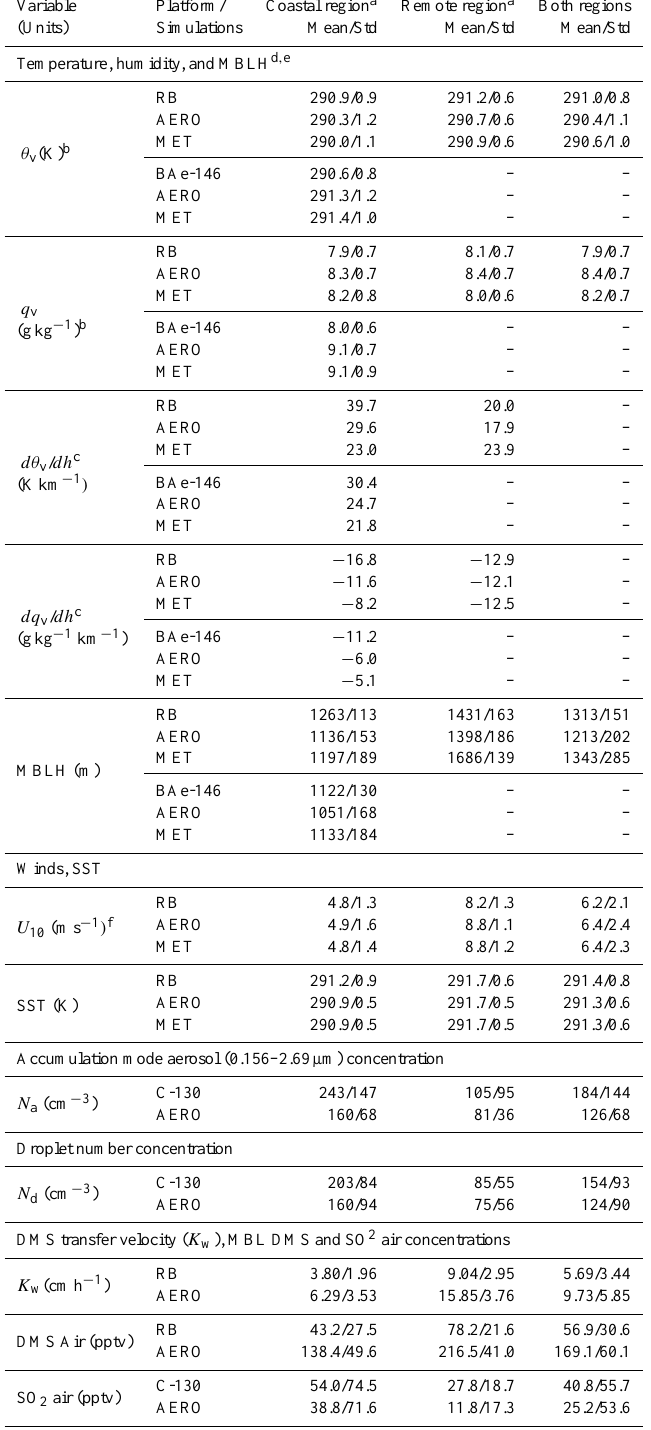
Table 3. Observed and simulated MBL temperature and humidity, 10-m wind speed, SST, and boundary layer